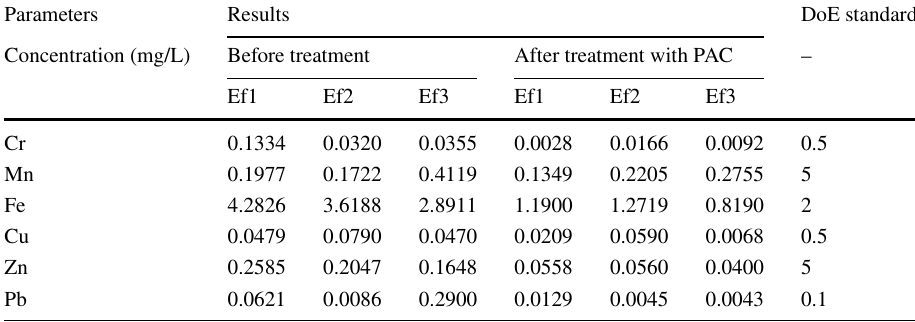
some heavy metals of textile dyeing effluents